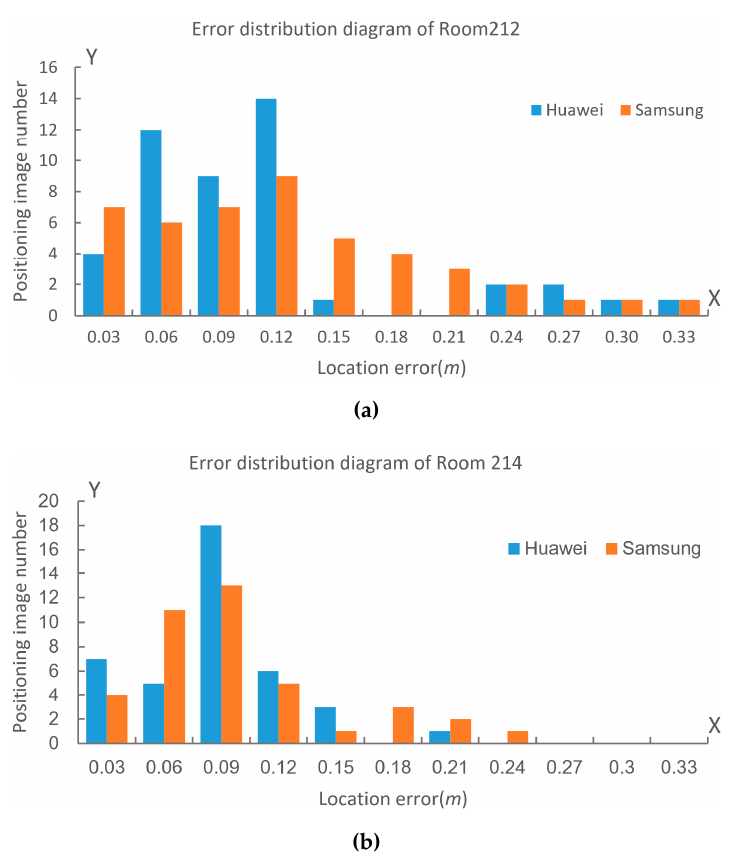
Figure 20. The location error distribution in different Rooms: (a) Room 212 and (b) Room 214.